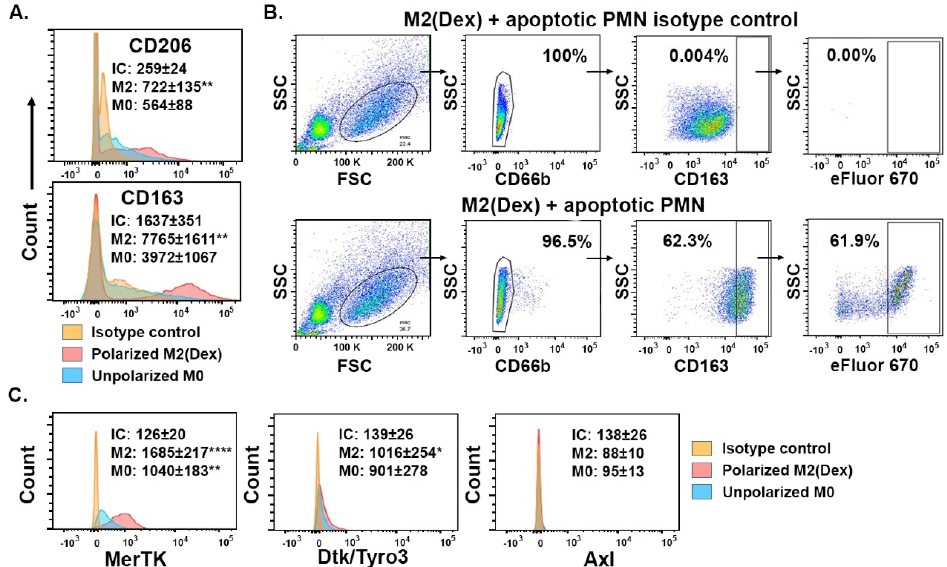
Figure 3. Monocyte-derived macrophages polarized by dexamethasone (M2(Dex) macrophages) expressed M2 markers and were highly efferocytic. ( A ) The histogram overlays showing the cell surface expression of CD206 and CD163 surface markers on M2(Dex) macrophages (red, M2), unpolarized M0 macrophages (blue, M0), or isotype control antibodies binding to M2(Dex) macrophages (light orange, IC). The mean fluorescence intensities (MFI) ± SEM of 10 independent donors are indicated; ( B ) The gating of efferocytosis by M2(Dex) macrophages shows (left to right) the successive exclusion of un-engulfed apoptotic PMN (FSC vs. SSC gate), the exclusion of macrophage cell surface bound CD66b + PMN, the inclusion of CD163 + M2(Dex) macrophages, and the percentage of CD163 + CD66b − macrophages containing engulfed eFluor670 + PMN. The lower panels show efferocytosis gating. The upper panels depict the staining of cells from the same experiment with the isotype control antibodies for CD66b and CD163; ( C ) M2(Dex) macrophages express MerTK and Tyro3 but not Axl TAM family members. MFI ± SEM of 10 independent donors are indicated. * p < 0.05, ** p < 0.01, and **** p < 0.0001 by one-way ANOVA with Tukey’s multiple comparison posttest compared to IC.